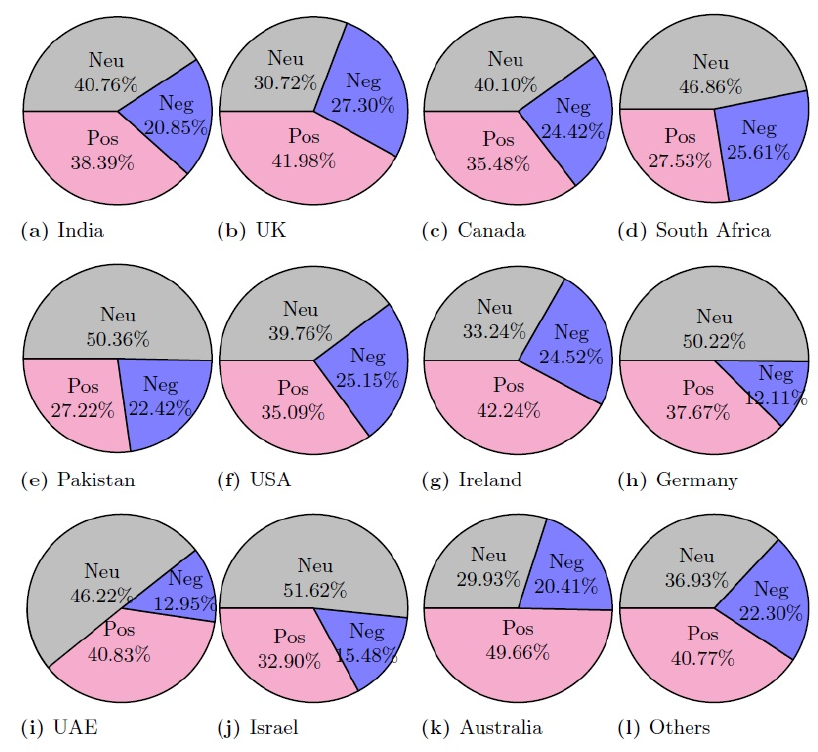
Figure 11. Percentage of the sentiment analysis for VADER.